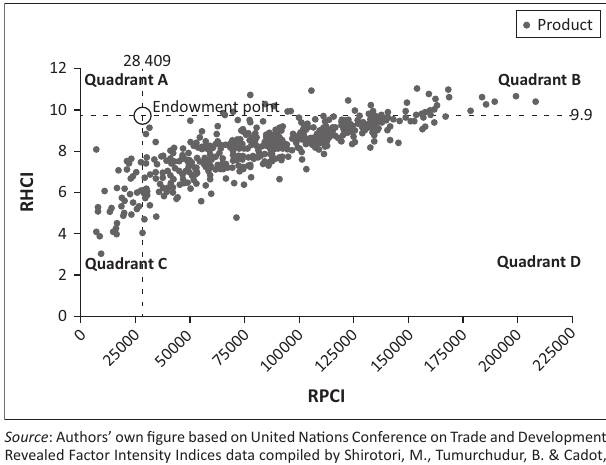
FIGURE 2: Factor intensities for products exported by South Africa which were selected in Step